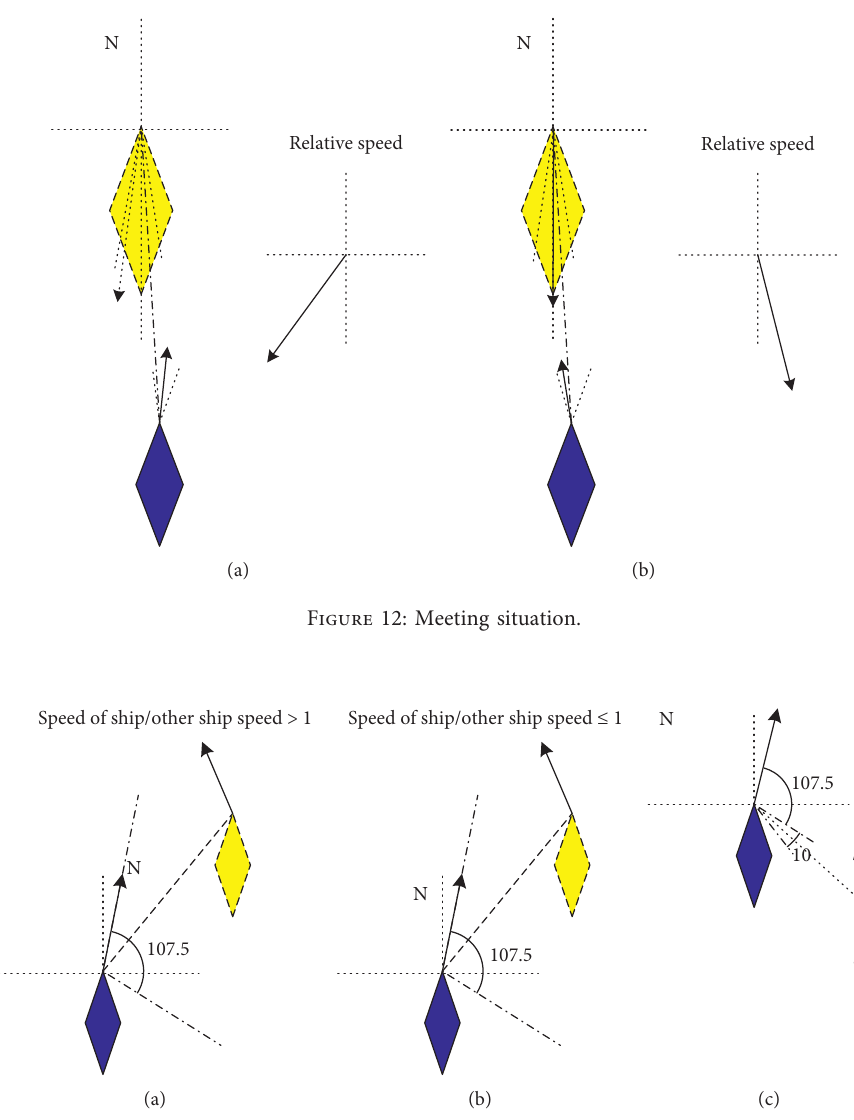
Figure 13: Crossing situation (own ship is a give way ship).